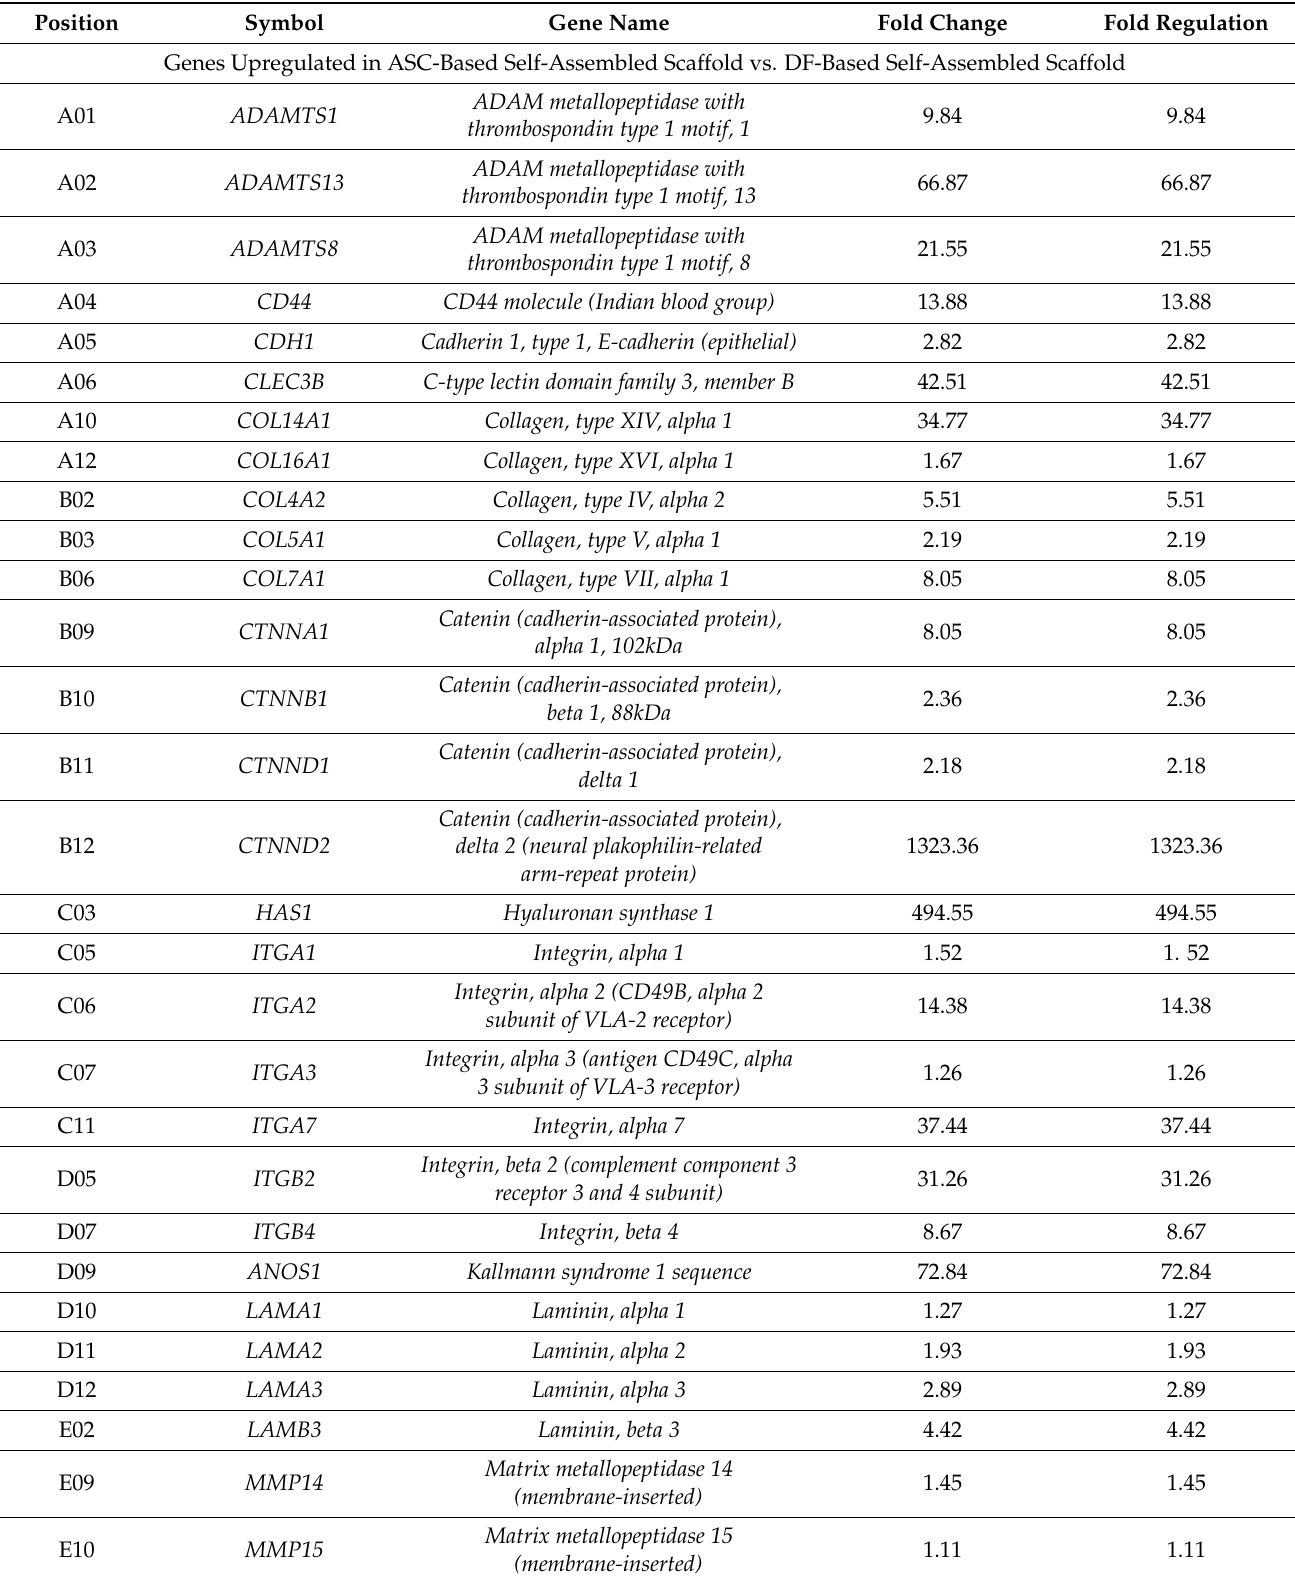
Table 1. Gene expression profile of ASC-based self-assembled scaffold and gene regulation status vs. DF-based self- assembled scaffold. Gene Name Fold Change Fold